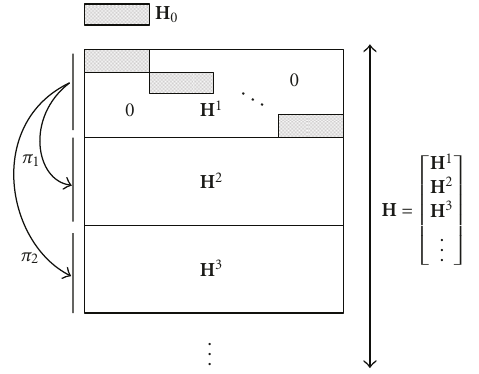
Figure 2: Structure of the parity-check matrix H of a GLD code.